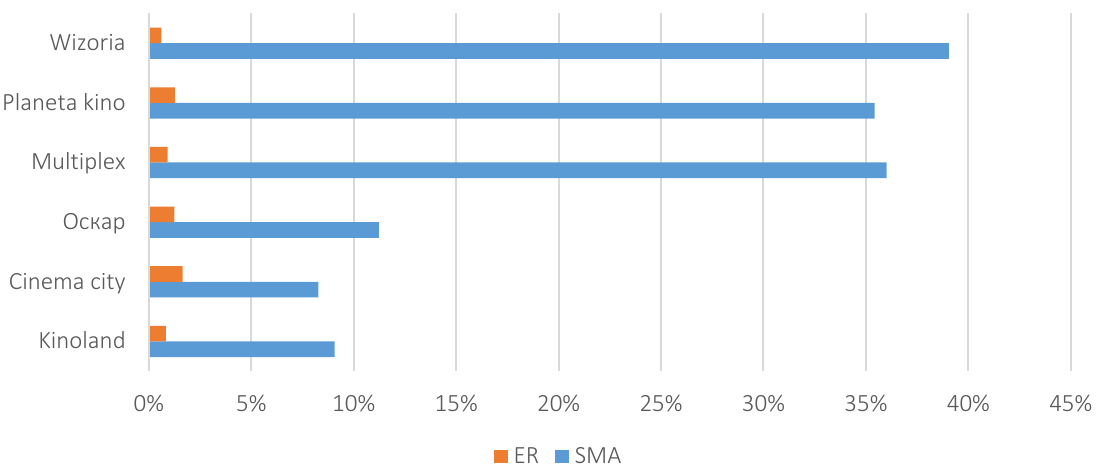
Figure 4. Activity and engagement indicators of the audience on Instagram